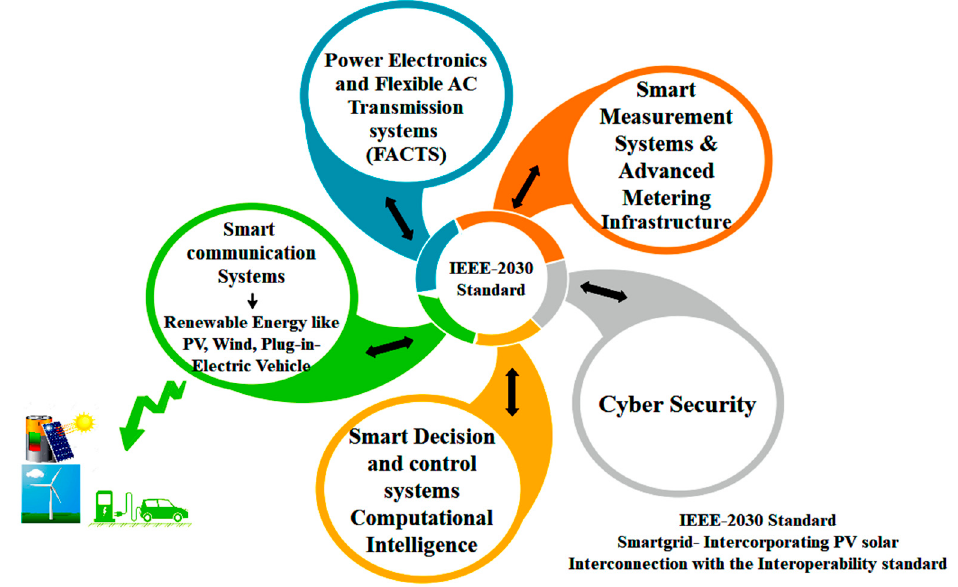
Figure 1. Schematic of Smart Grid Interoperability Standard.